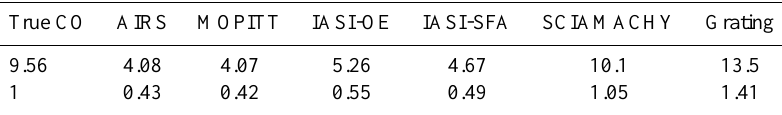
Table 1. CO TC (in units × 10 18 moleccm − 2 ) calculated according to Eq. (1) with a “true” CO profile for Moscow around 11:30 Moscow local time (7ppm of CO VMR from the surface to 300m above the surface; 0.22ppm between 300m and 5000m above the surface; then gradual decline down to 0.026ppm near the tropopause). A priori profiles correspond to those used normally for each data set. AK correspond to Fig. 2. Bottom row is a relation of convolved value to the truth.